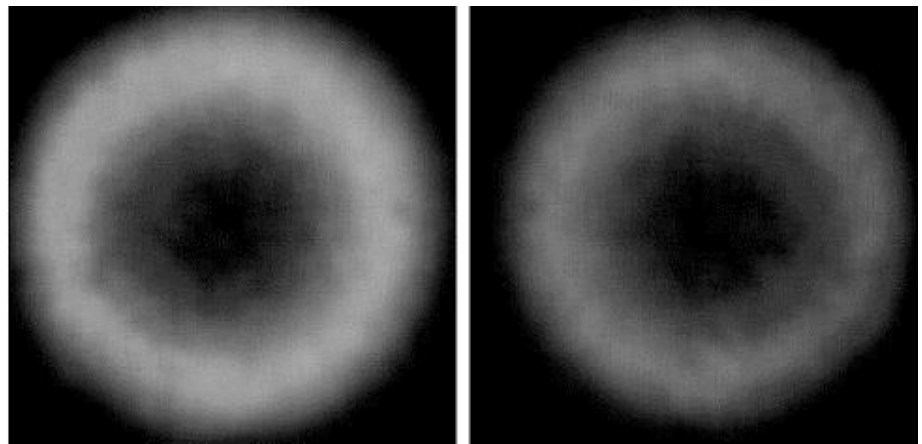
Figure 18. Far-field ring pattern of MPD: (left) after sensor exposure to HCl vapor and (right) after sensor exposure to NH3 vapor.